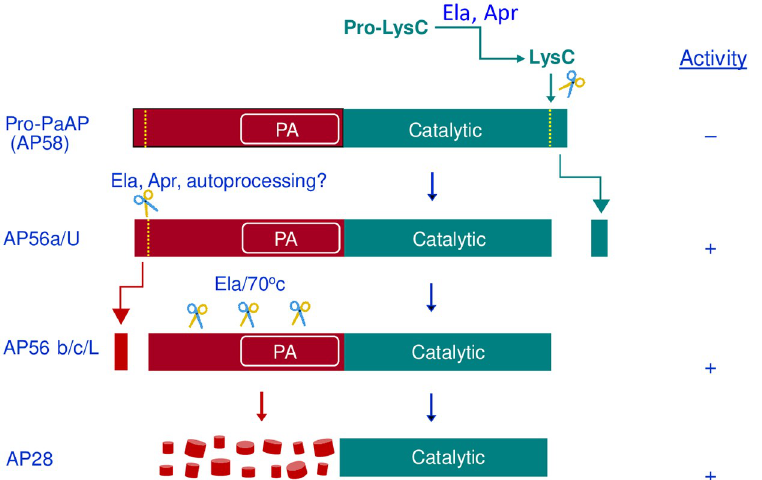
Fig 6. Domain structure of pro-PaAP and active forms of PaAP produced by specific P . aeruginosa proteases. Brown , N-terminal non-catalytic domain; PA , protease associated domain; dark green , catalytic domain. Activation results from C-terminal processing by LysC, apparently after activation by Ela and/or Apr. Cleavage by LysC generates AP56a/U; Table 1, Fig 5D). AP56a/U can be processed further at the N-terminus by Ela, Apr, or autocatalytically (or other proteases), generating AP56b/L or AP56c (Table 1; Figs 1C and 5D), apparently without effect on activity. The catalytic domain (AP28) can be released by heating of AP56 at 70˚C in the presence of Ela [9]. This involves degradation of the non-catalytic domain into peptides, which may be degraded further by AP28